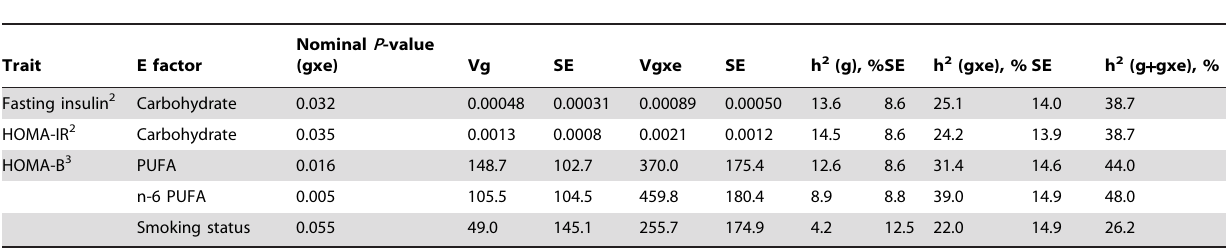
Table 2. Estimation of additive genetic variance and variance of GxE interaction for diabetes-related traits 1 .